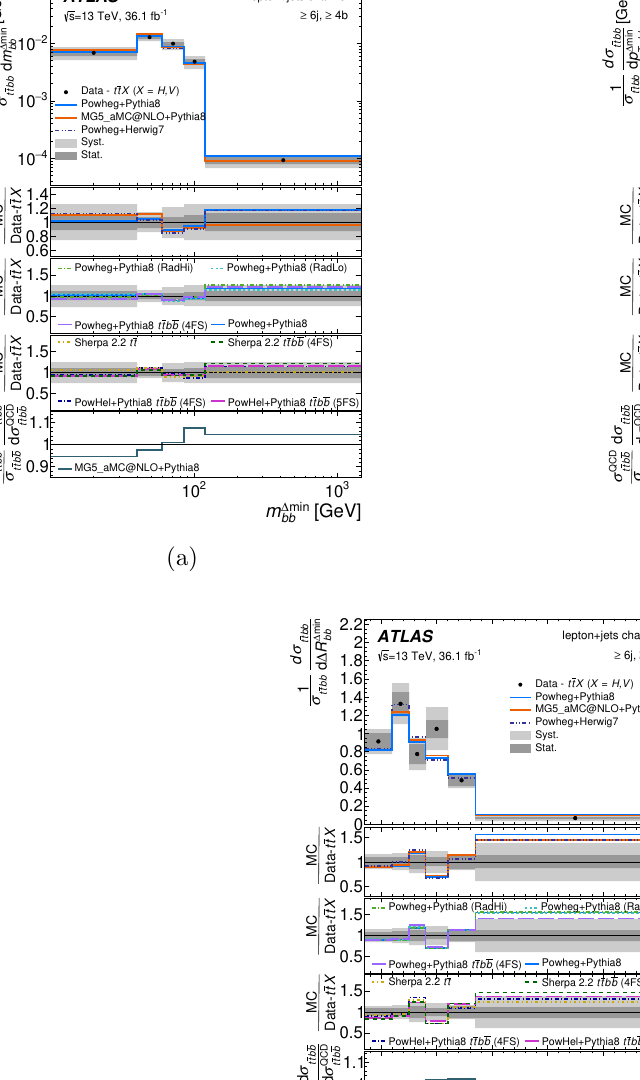
, (b) p (cid:1)min and (c) bb T ;bb